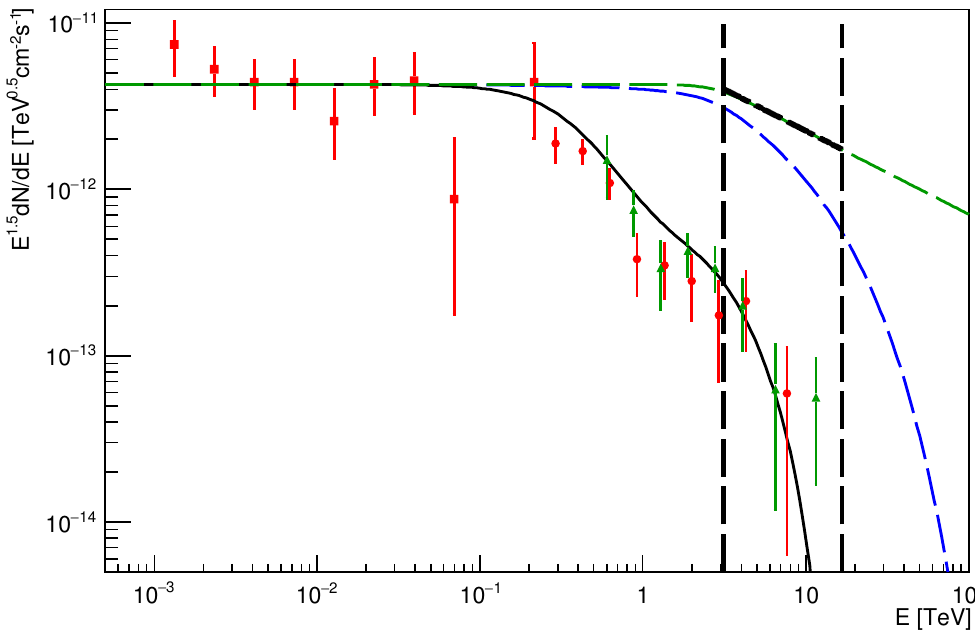
Figure 4. The high-energy part of the SED for 1ES 0229+200 and the corresponding model curves accounting the intrinsic absorption, but neglecting EBL absorption (blue curve) and without the account of both absorption effects (green curve). Black dashed segment denotes a dN / dE ∝ E − 2 dependence. Upper limits are not